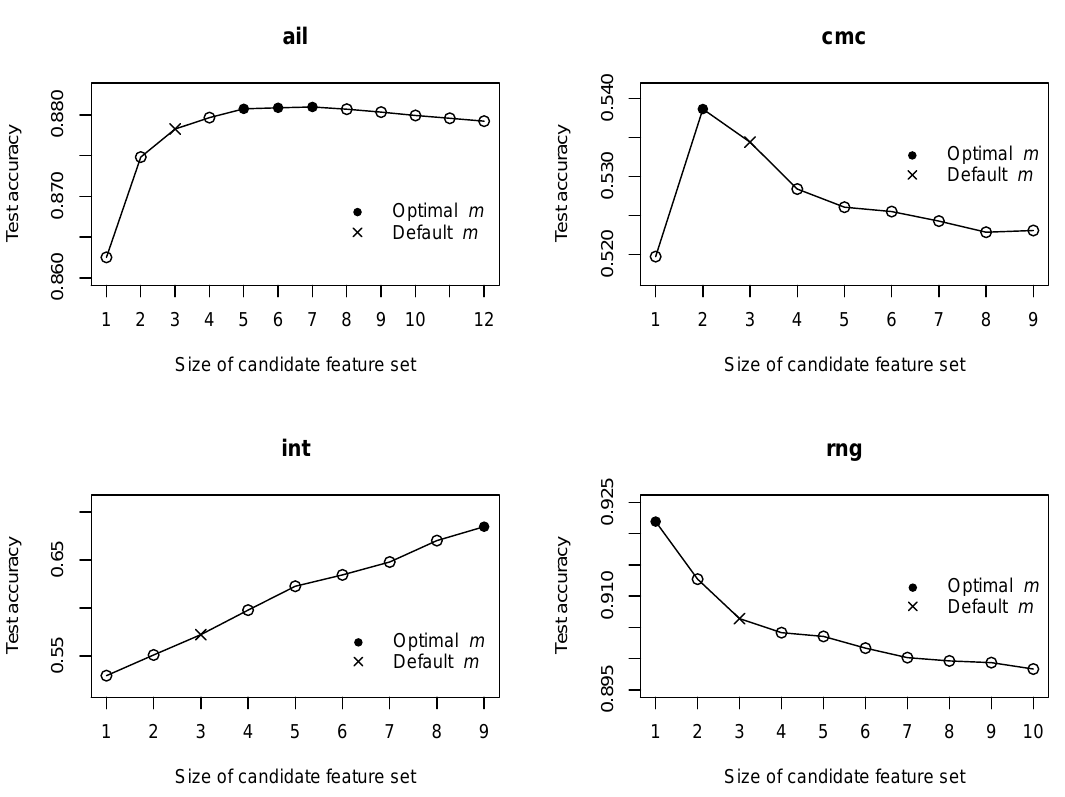
Figure 1. Accuracies for each size of candidate feature